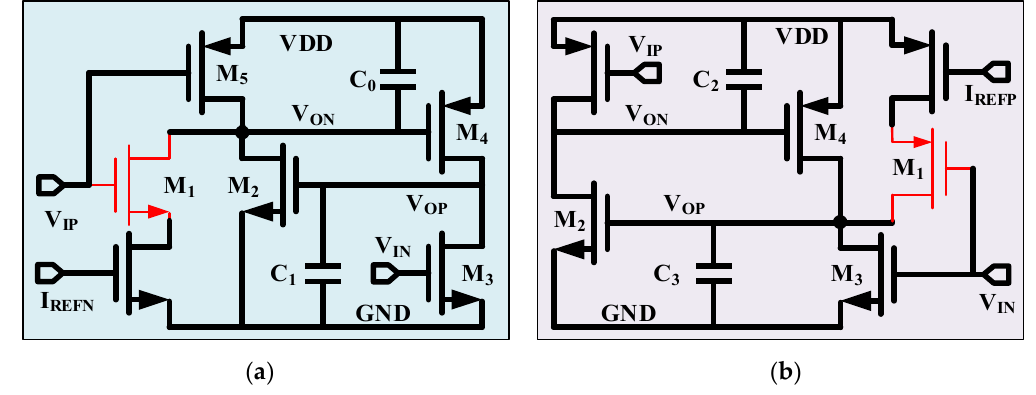
Figure 5. Detail of delay cell ( a ) Delay_Cell_P ( b ) Delay_Cell_N.